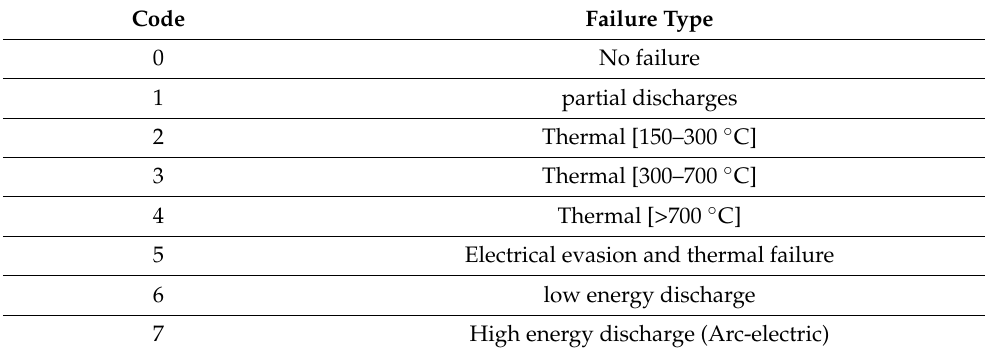
Table 25. Codification of types of